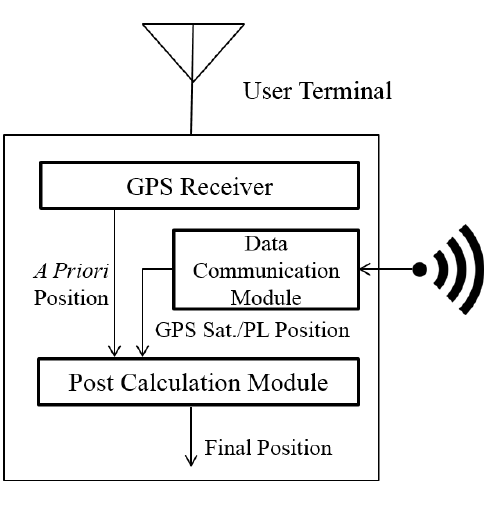
Figure 4. Block diagram of user